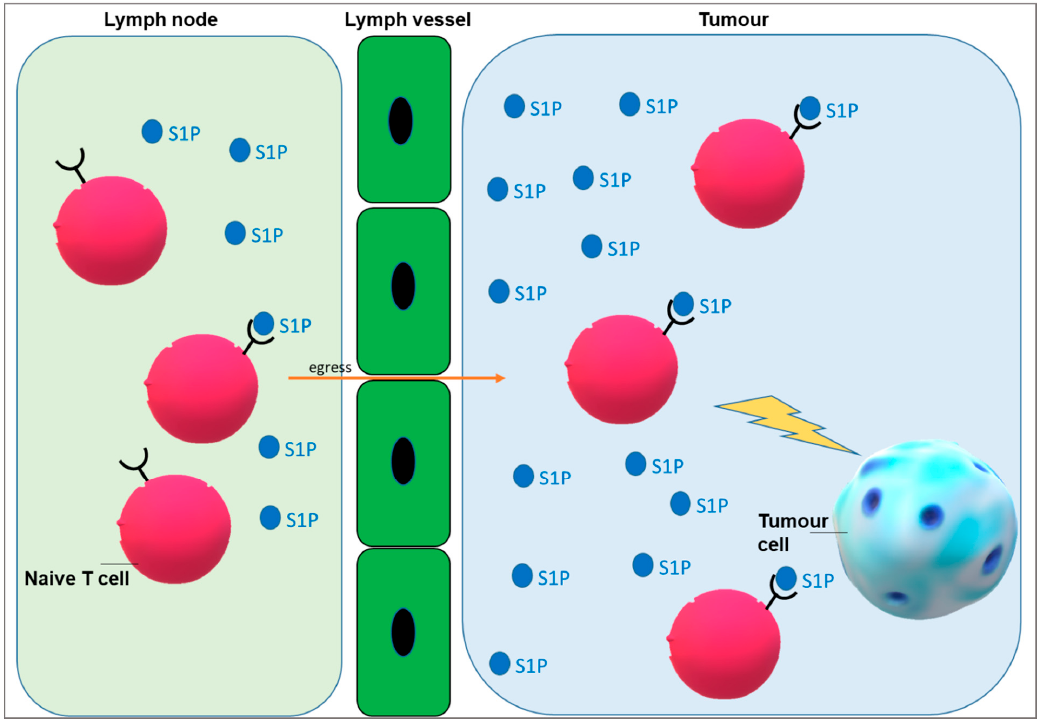
Figure 1. Model of the role of S1P (sphingosine 1-phosphate) in T cell egress and migration in tumour milieu. T cells express surface S1PR1 (sphingosine 1 phosphate receptor 1) when they are inside the lymphoid tissue. S1PR1-mediated S1P signalling in T cells is needed for the exit from the lymphoid tissue.